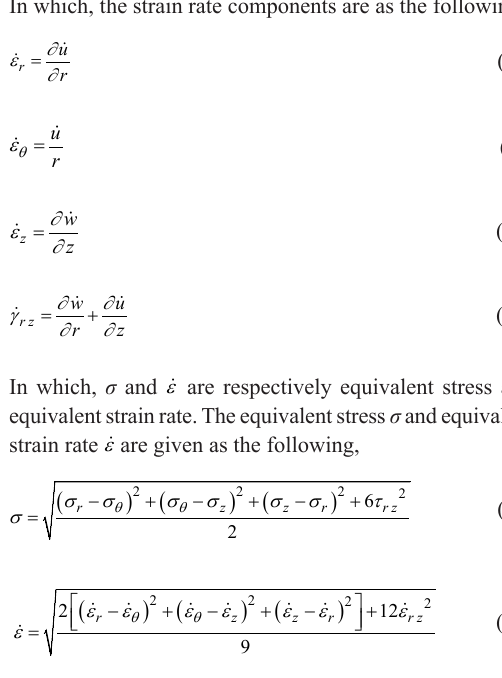
Figure 1. A model of the unit cell for modeling the complete short fiber composite.